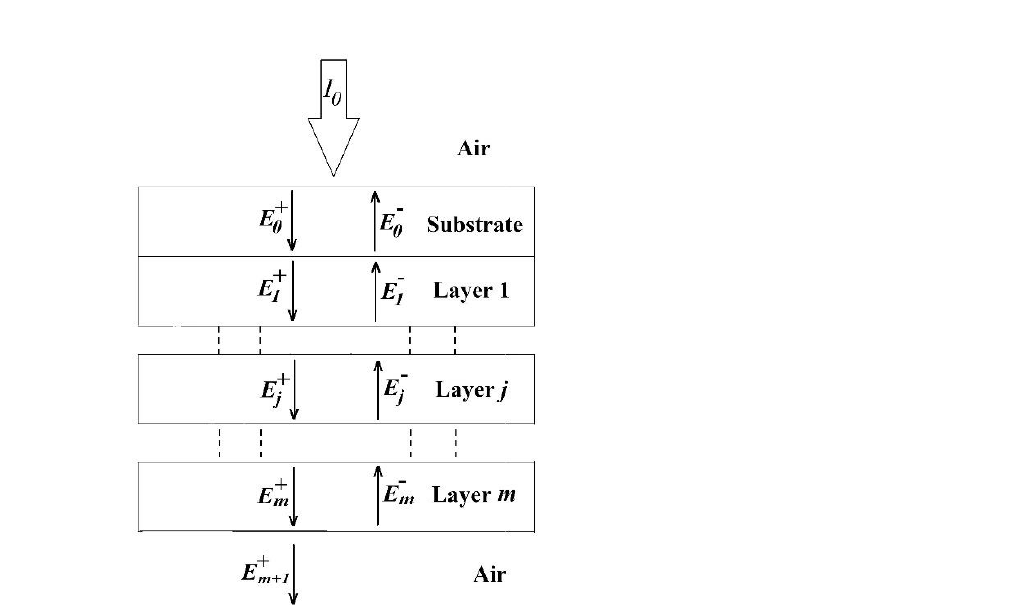
Figure 1. Schematic diagram of a bulk-heterojunction organic solar cell (BHJ OSC) as a multilayer stack suitable for the optical transfer matrix method (OTMM). The electric field components of the incident and reflected electromagnetic waves in the l th layer are represented by 𝐸 𝑙+ and 𝐸 𝑙− , respec- tively, where 𝑙 = 0,1,… 𝑗 … , 𝑚 + 1 and j denotes the active layer.